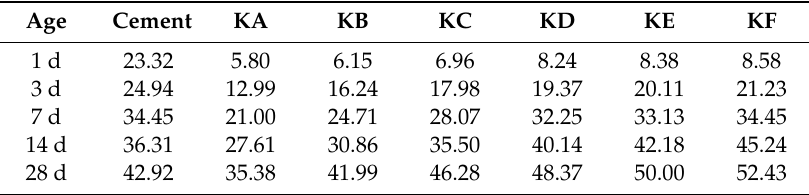
Table 3. Compressive strength of specimen, MPa.